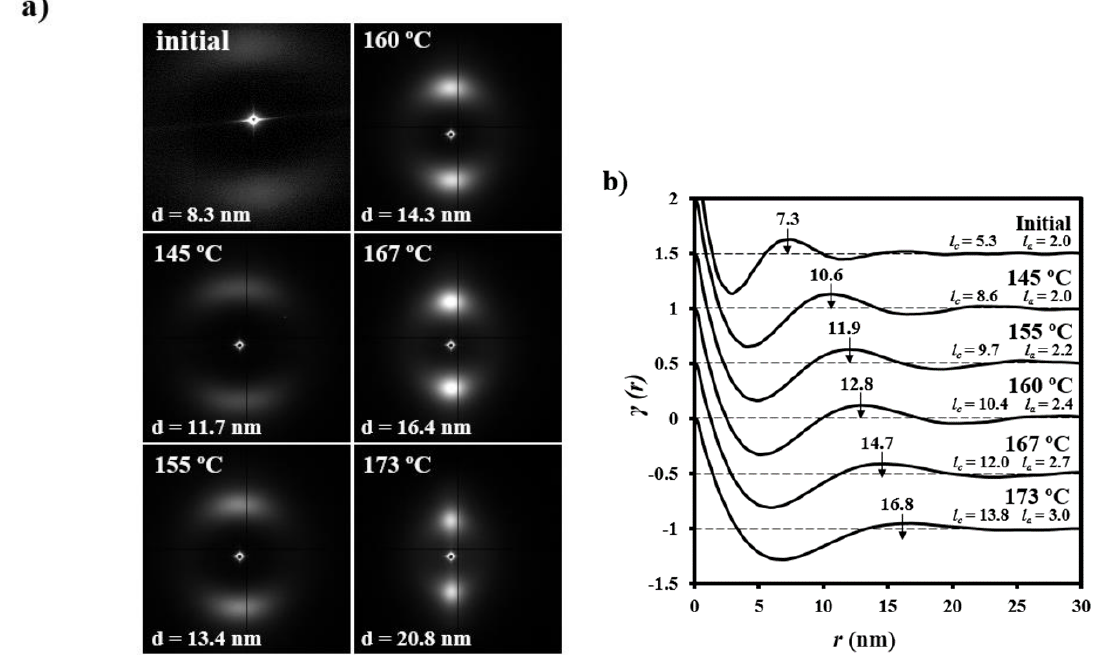
Figure 14. ( a ) SAXS patterns of the initial γ irradiated GL- b -[GL- co- TMC- co -CL]- b -GL sample taken at representative temperatures during a heating run at 10 °C/min (up); ( b ) Change on the correlation function during a heating run at 10 °C/min of the initial γ irradiated GL- b -[GL- co -TMC- co -CL]- b -GL